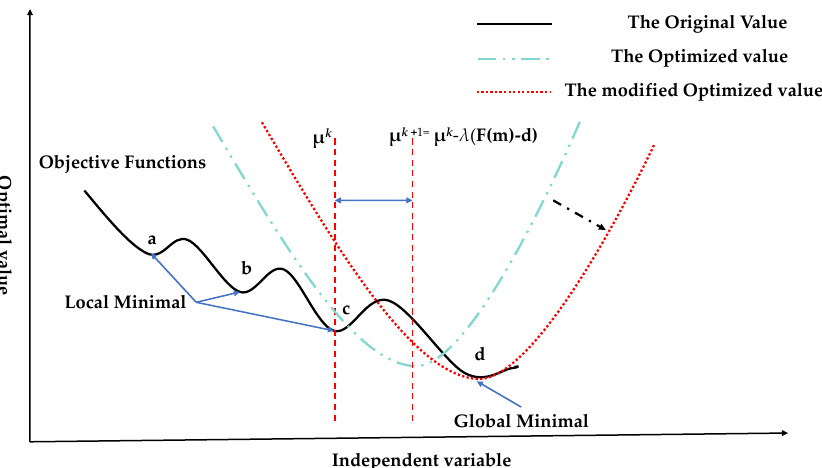
Figure 1. Multiplicative multi-scale correction process for data. a, b, and c are those local minimals; d is the global minimal.